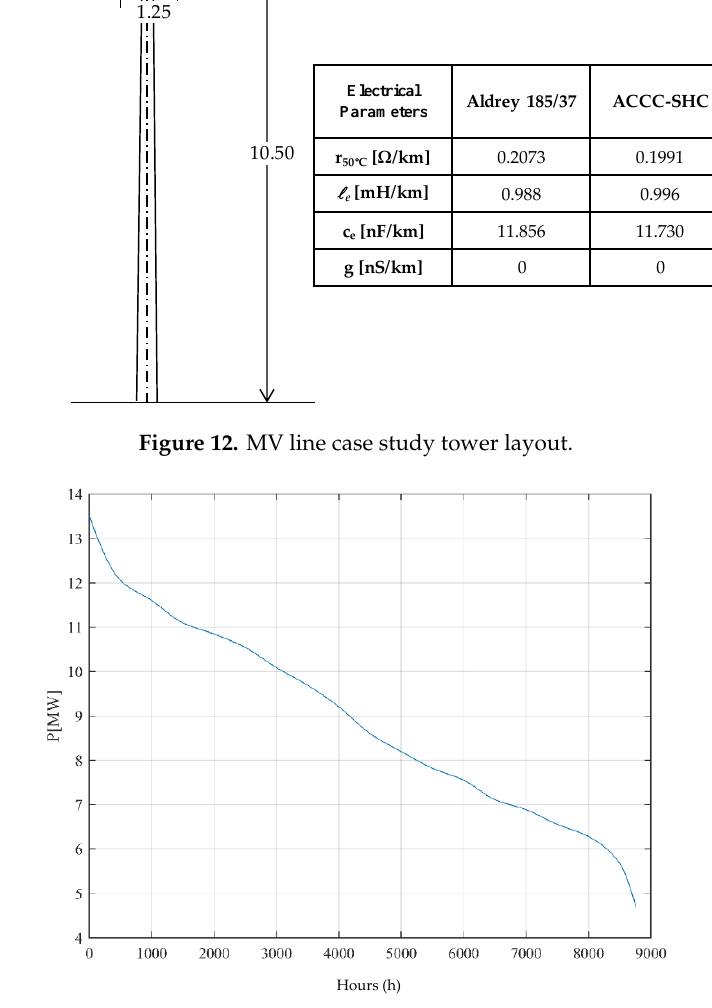
Figure 13. Duration curve assumed for the distribution OHL case study. Table 14. Comparison between traditional and innovative conductors for HV